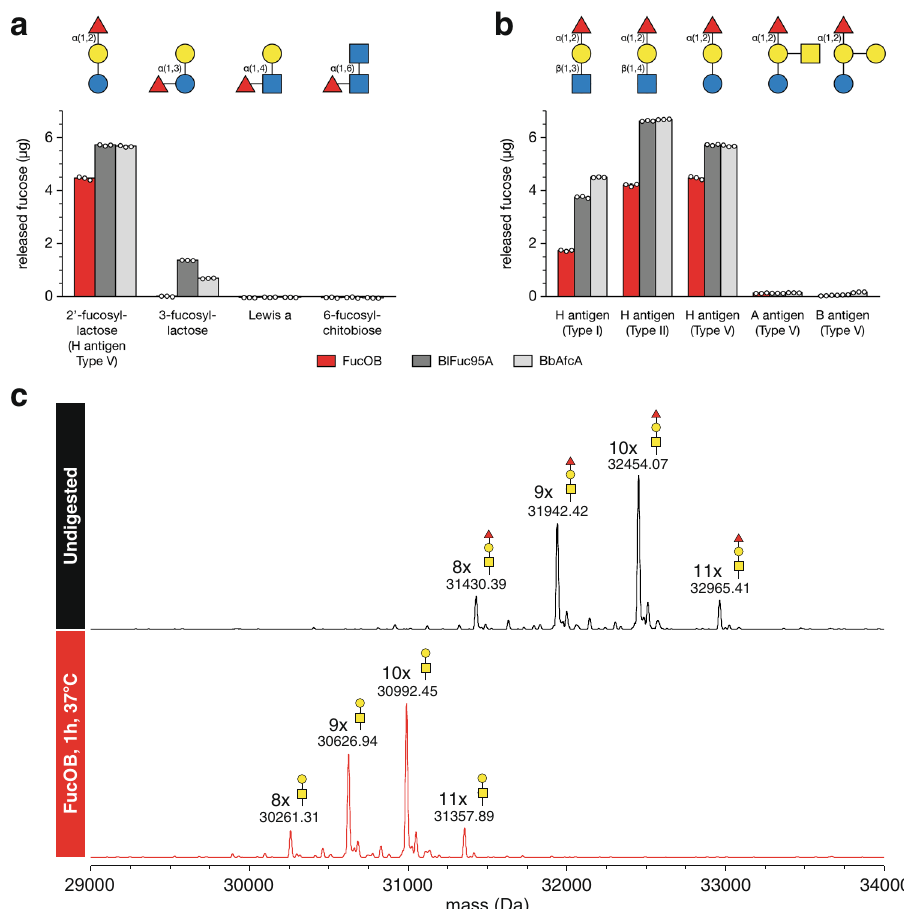
Fig.2|Substratespeci fi cityofFucOB.a , b Quanti fi cationofreleasedfucoseafter incubation of synthetic oligosaccharides with FucOB, Bi Fuc95A, and Bb AfcA for 30min at 37°C. Free fucose levels were quanti fi ed spectrophotometrically and compared to a standard curve of known concentrations. Bars and error bars represent the mean and standard deviation of triplicate measurements (shown as